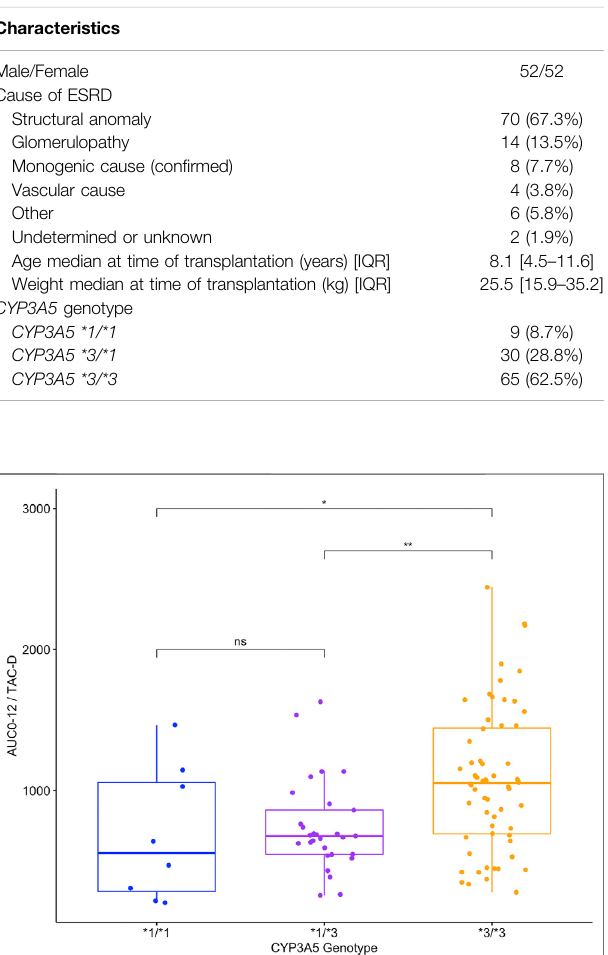
Table 1 . The median age at the time of transplantation was 8.1 years, and the leading cause of the end stage renal disease to require transplantation was a structural anomaly.